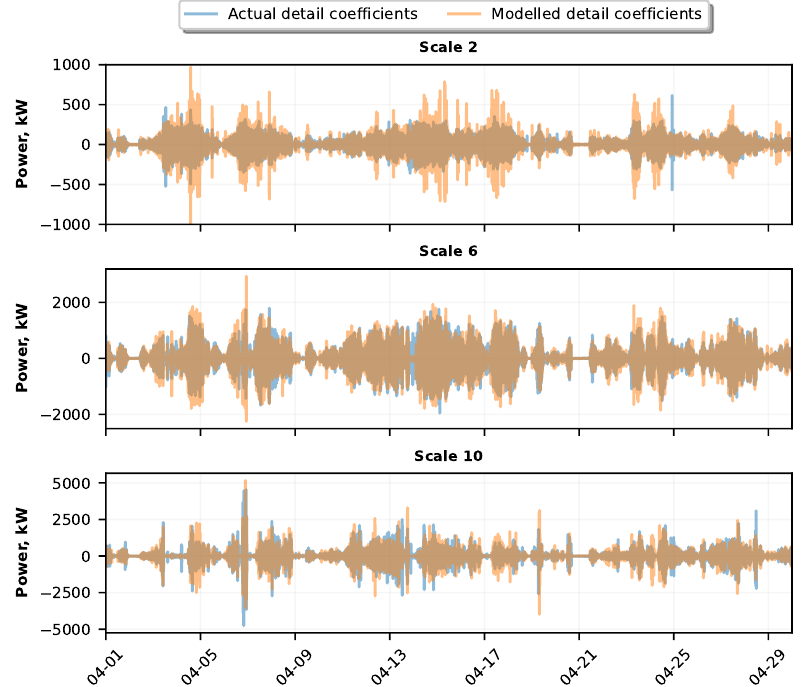
Figure 5. Comparison of power production detail coefficients between 8 aggregated WTGs (actual) and model for scales 2, 6, and 10 for the month of